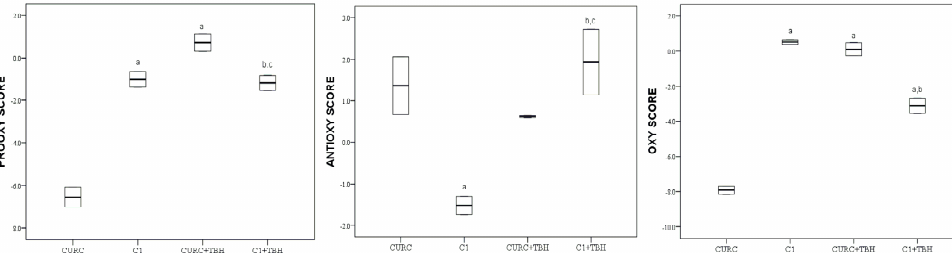
Figure 4. Values of pro-oxidative, antioxidative and oxidative scores of curcumin (CURC) and its derivative (C1) in serum pool before and after the addition of TBH; values are represented by median (horizontal line) and interquartile range (25–75th percentile (lower and upper edge, respectively)). a,b,c,—significant difference ( p < 0.05)compared to CURC, C1, CURC + TBH, C1 + TBH, respectively. A significantly ( p < 0.05) lower value of oxidative score of curcumin (CURC), in comparison to its derivative (C1), was observed. The addition of TBH changed the oxidative score of all compounds significantly ( p < 0.05). After the addition of TBH, the oxidative score of CURC+TBH was significantly ( p < 0.05) higher than that of C1 +